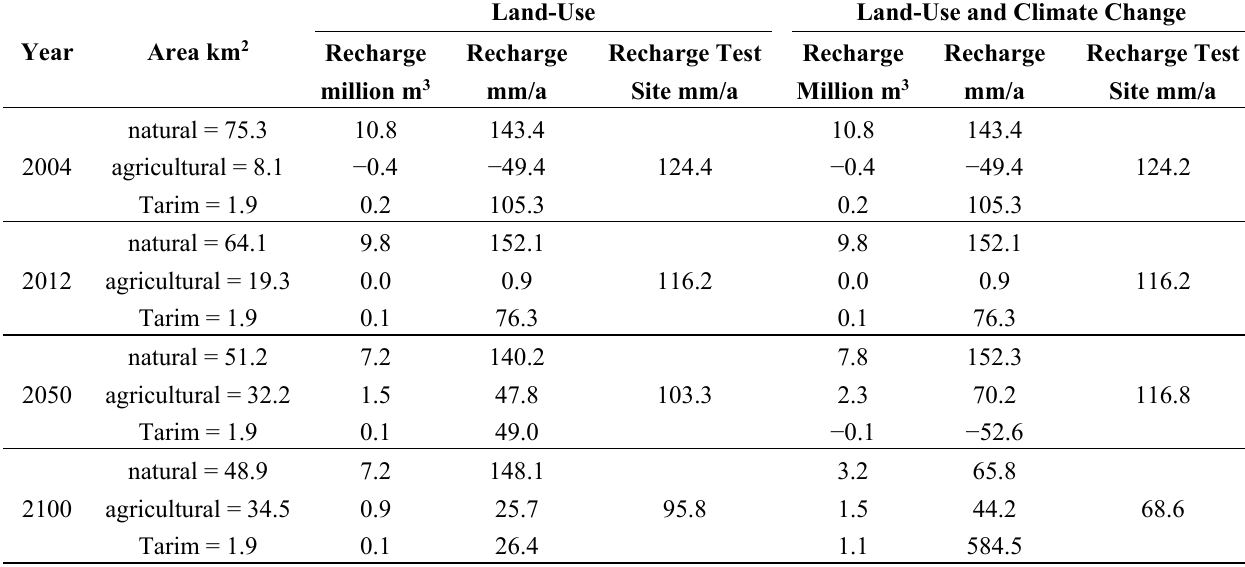
Table 2. Changes in groundwater recharge in natural areas, agricultural areas, and the Tarim River in the past, present, and future. Land-Use Land-Use and Climate Change Year Area km 2 Recharge Recharge Recharge Test Recharge Recharge Recharge Test million m 3 mm/a Site mm/a Million m 3 mm/a Site mm/a natural = 75.3 2004